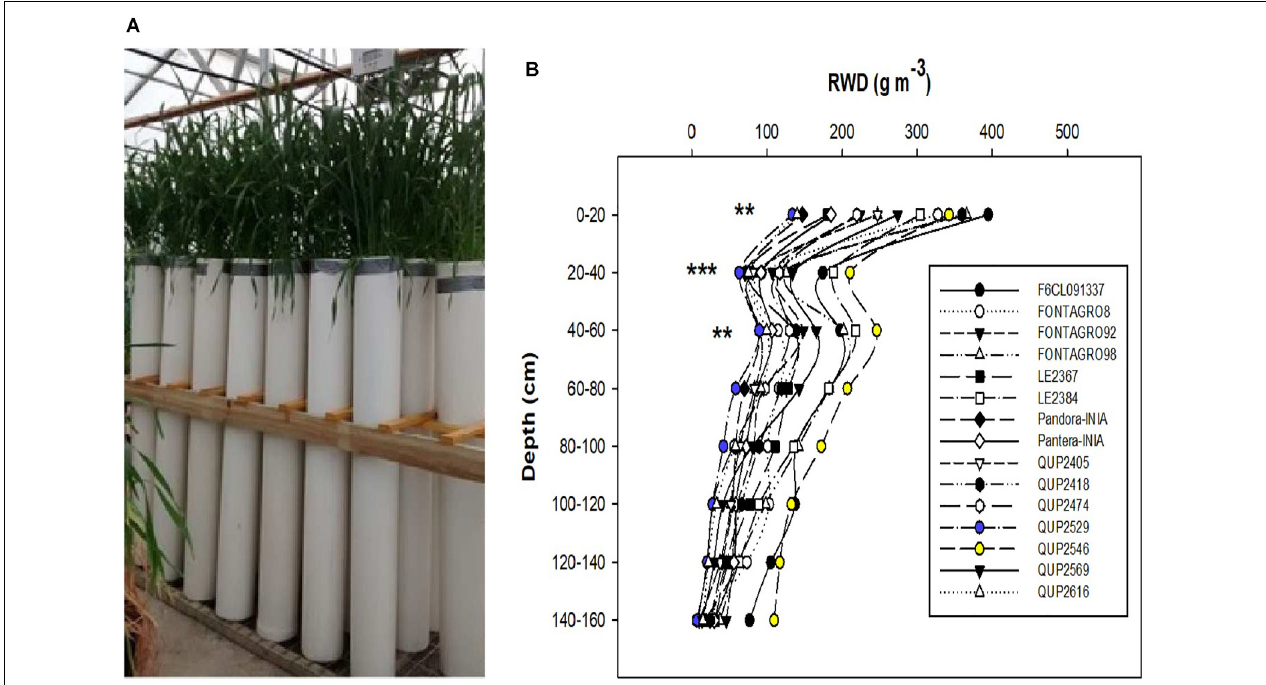
FIGURE 1 | (A) Wheat genotypes growing in PVC tubes of 16 cm diameter and 160 cm length in a heated glasshouse, and (B) distribution of root biomass in soil depth of the 15 genotypes grown under well-watered regime in 2015. ** P ≤ 0.01 and *** P ≤ 0.001 are obtained from ANOVA test of the different genotypes at the different soil column